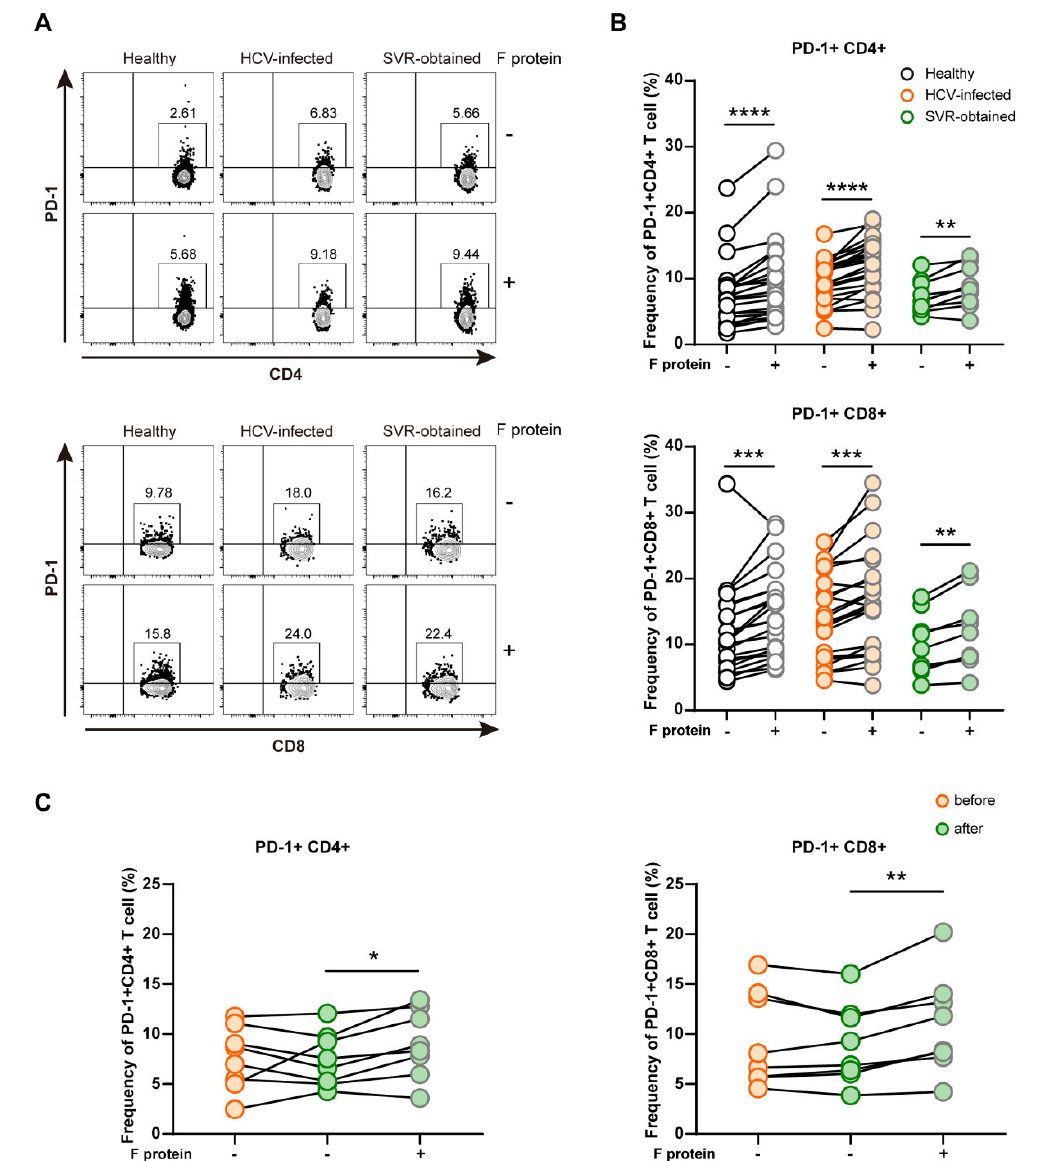
Figure 6. Changes in the frequency of PD-1-expressing CD4+ and CD8+ T cells in PBMCs before and after the stimulation with the HCV F protein. ( A ) Representative flow cytometry plots of PD-1+CD4+ T cells and PD-1+CD8+ T cells following an ex vivo stimulation with or without the F protein. Each incubation was performed in triplicate. The analysis was performed using the PBMCs of a healthy cohort (n = 22), HCV-infected cohort (n = 23), and SVR-obtained cohort (n = 9). ( B ) Dot plot displaying the frequency of PD-1-expressing CD4+ and CD8+ T cells in PBMCs with or without the F protein in three cohorts. ( C ) Dot plot displaying the frequency of PD-1-expressing CD4+ or CD8+ T cells in the PBMCs of 8 paired chronic hepatitis C patients before treatment with DAAs, after treatment without the F protein stimulation, and after treatment with the F protein stimulation. Statistical analyses were performed using the paired t -test. * p < 0.05, ** p < 0.01, *** p < 0.001, **** p <